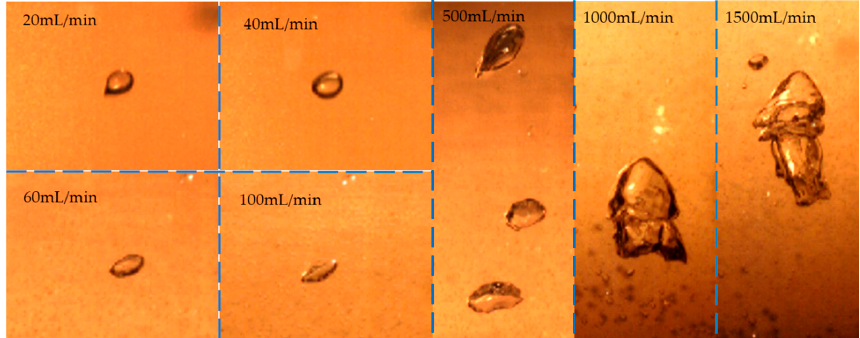
Figure 2. Bubble shape at different gas flow rate with oil phase viscosity of 50 cSt.